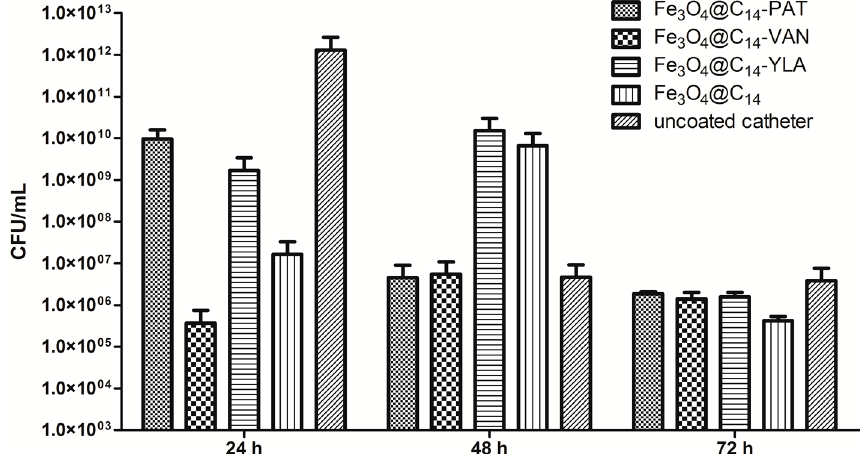
Figure 5. Number of K. pneumoniae viable cells recovered from the biofilms developed on the catheter specimens coated with different essential oils containing nanosystems and on the uncoated catheters tested after 24, 48 and 72 h. Each column represents the average (Av) values of three